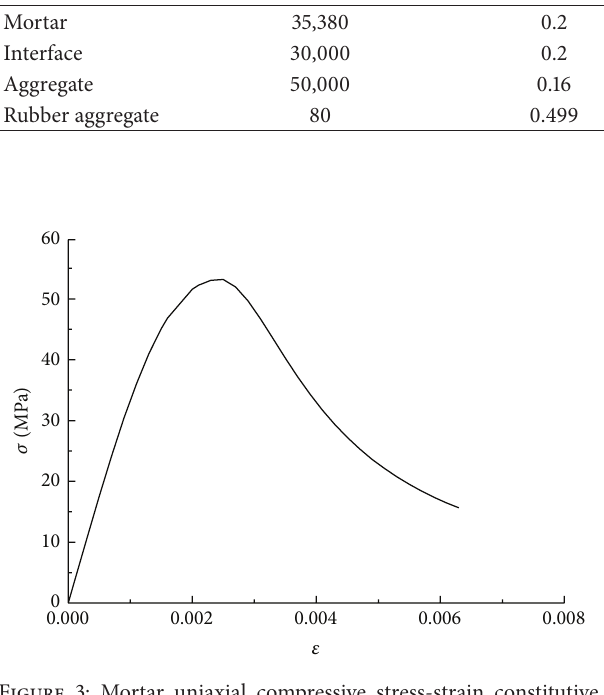
Figure 3: Mortar uniaxial compressive stress-strain constitutive